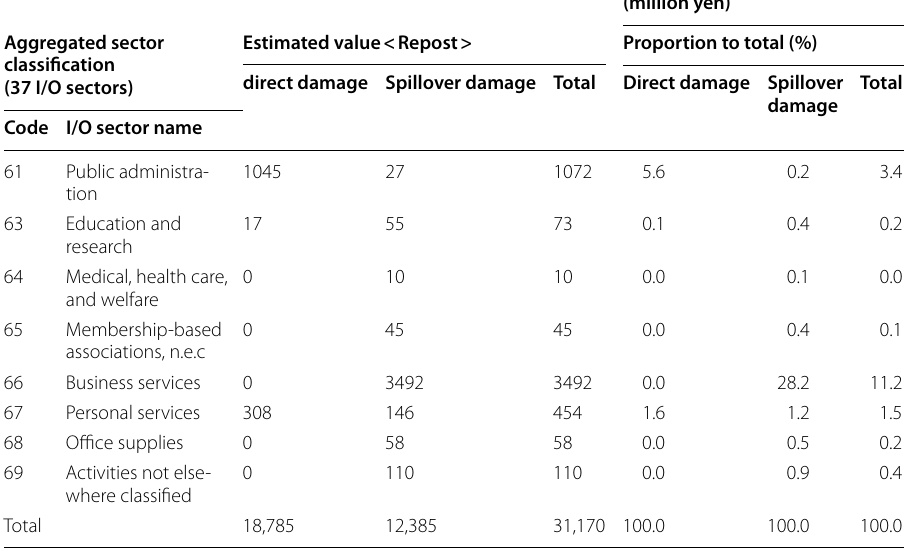
Table 5 Summary of the top 5 I/O sectors Aggregated sector classification (37 I/O